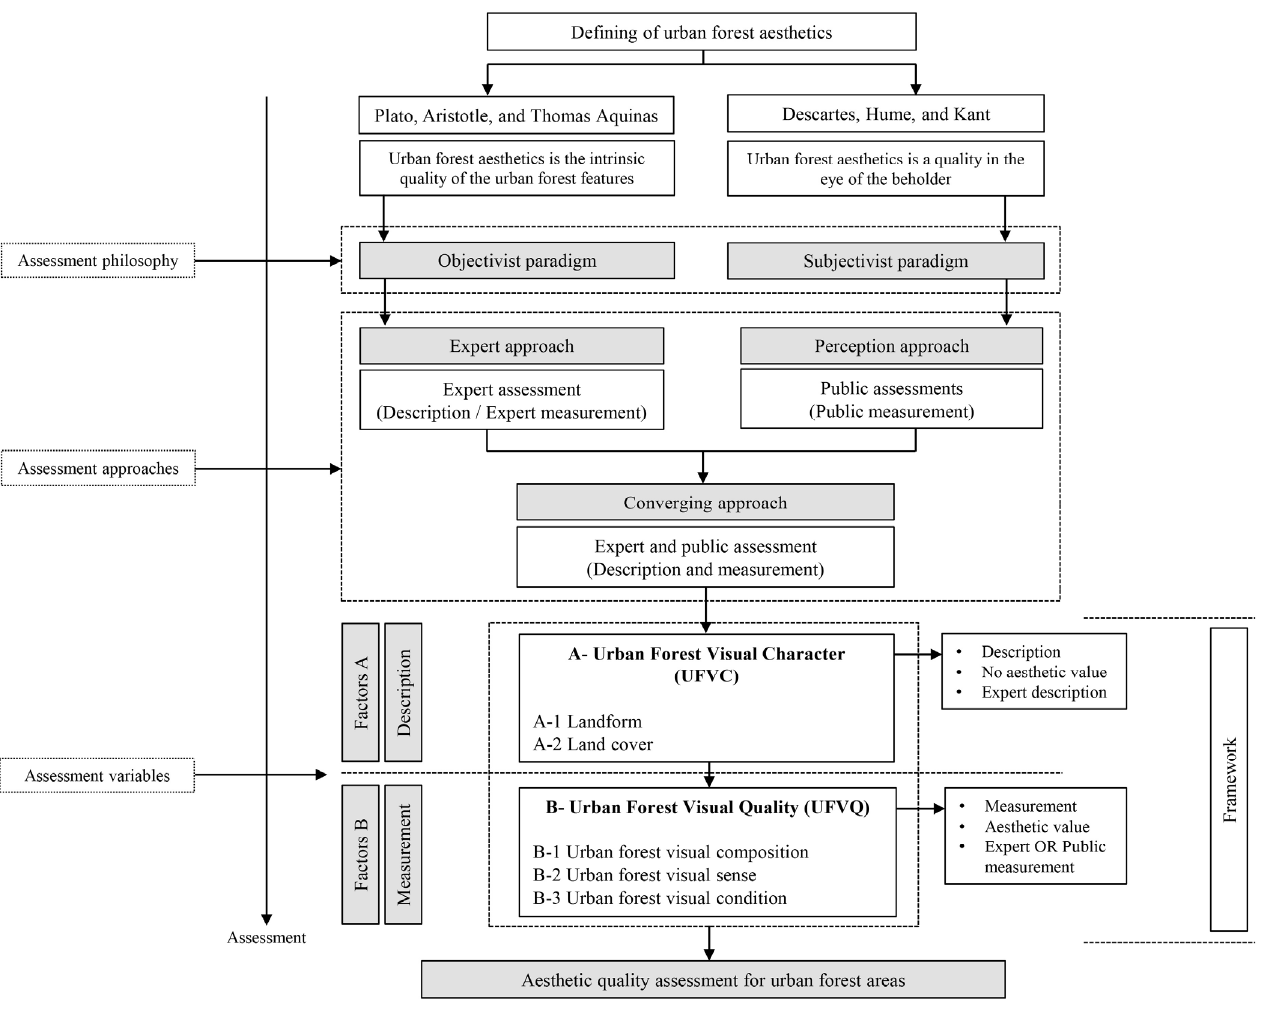
Figure 2. A framework for aesthetic quality assessment of urban forest areas.